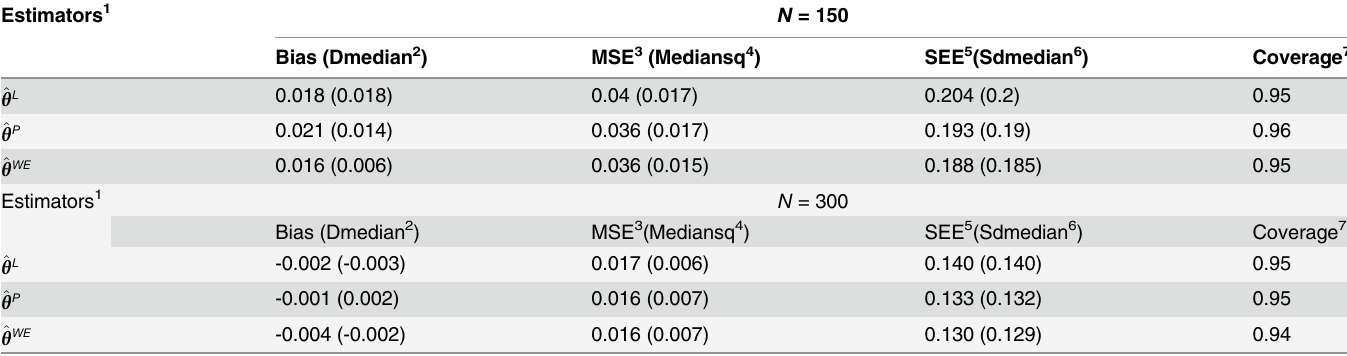
Table 1. Simulation result when N = 150 and N = 300, ρ = 0 with covariate Bernoulli(0.5). Estimators